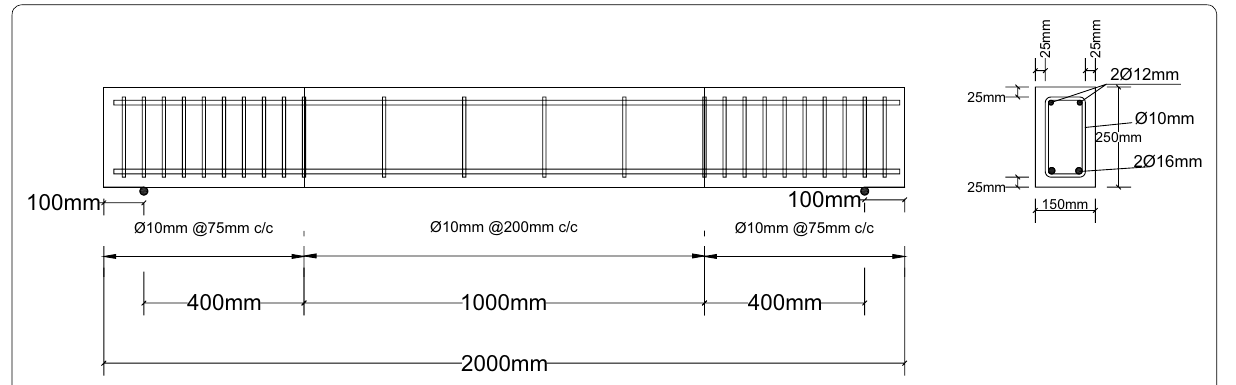
Fig. 1 Dimensions and reinforcement details of the test